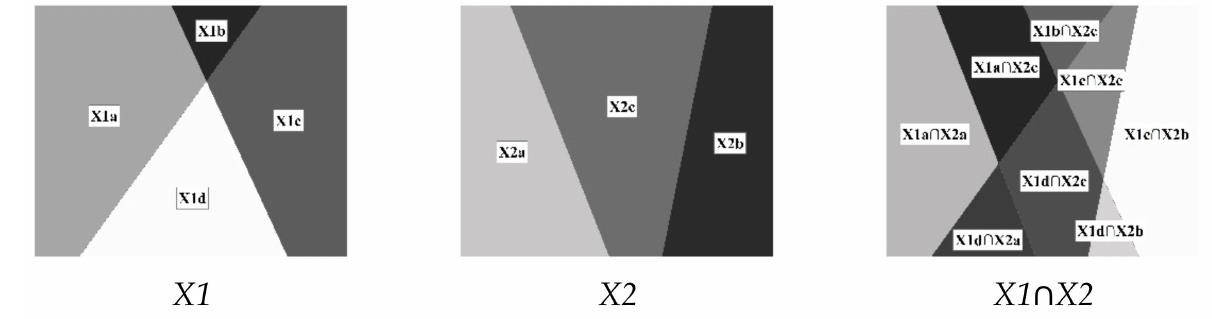
Figure 5. Diagrammatic sketch that GeoDetector used to detect the interaction between explanatory variables X 1 and X 2.